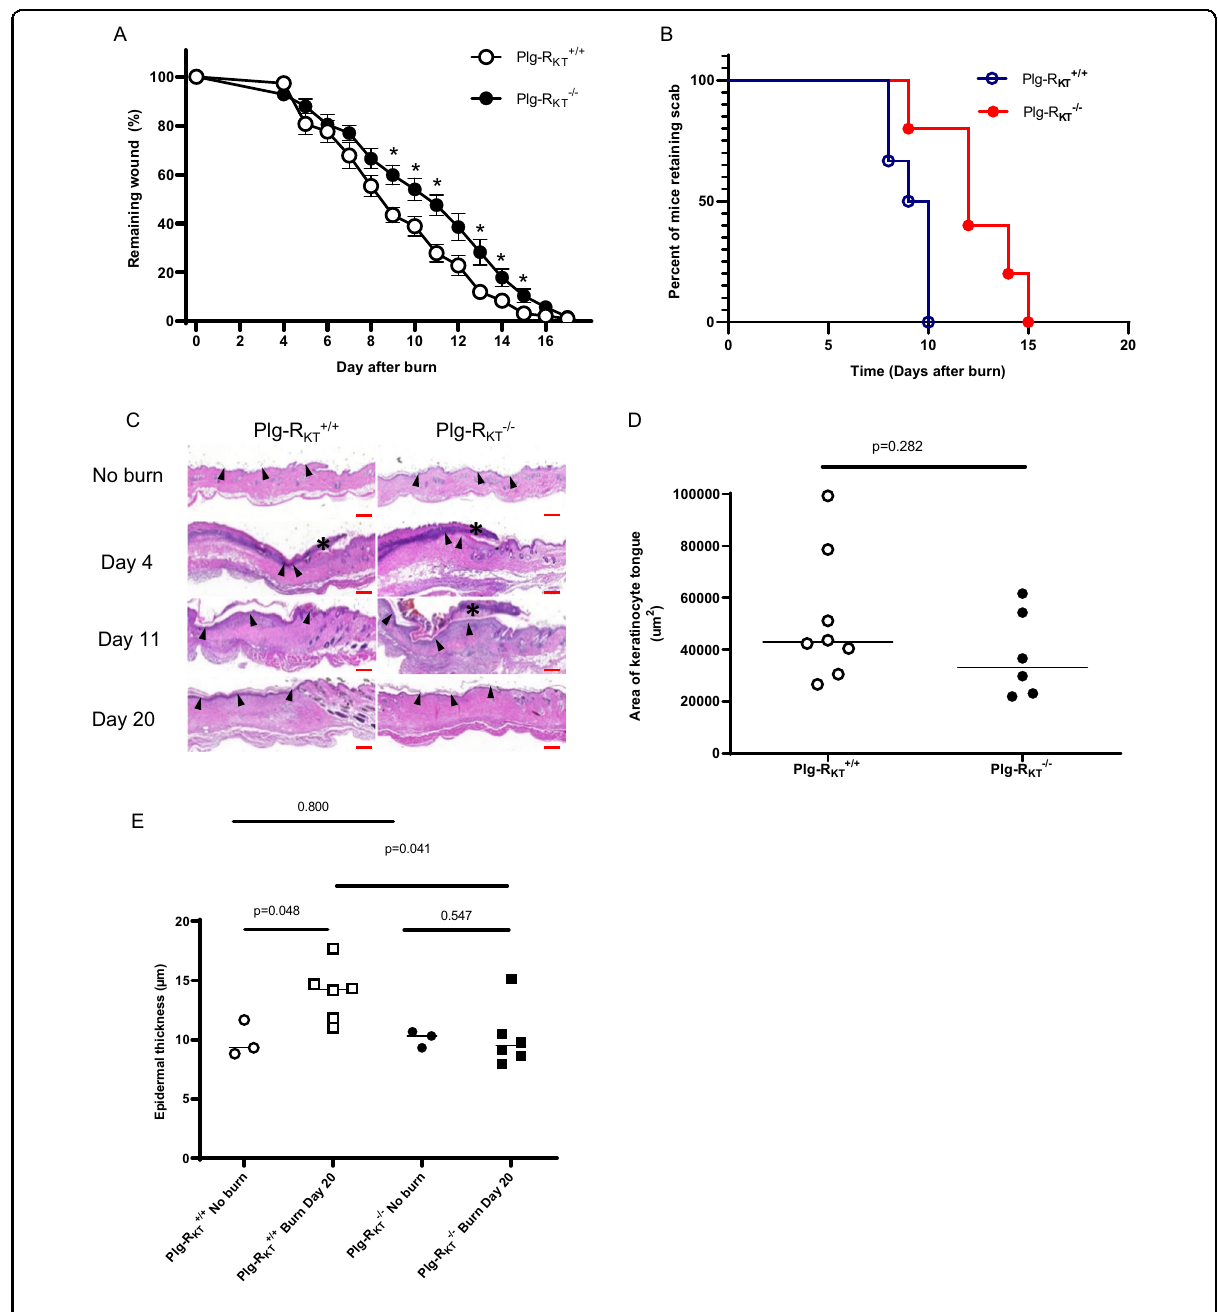
Fig. 1 (See legend on next